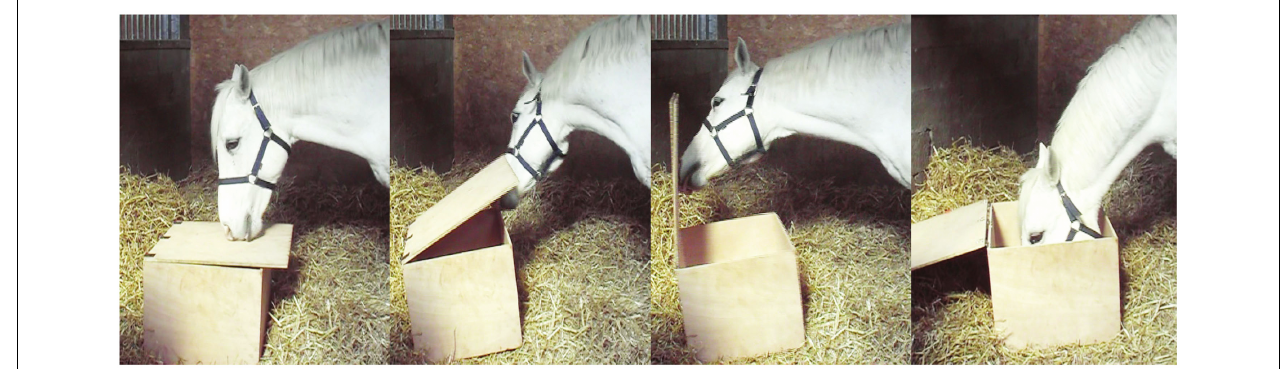
FIGURE 1 |The chest test: example of behaviors. Sniffing the lid/Lifting the lid/Opening the chest/Eating food.